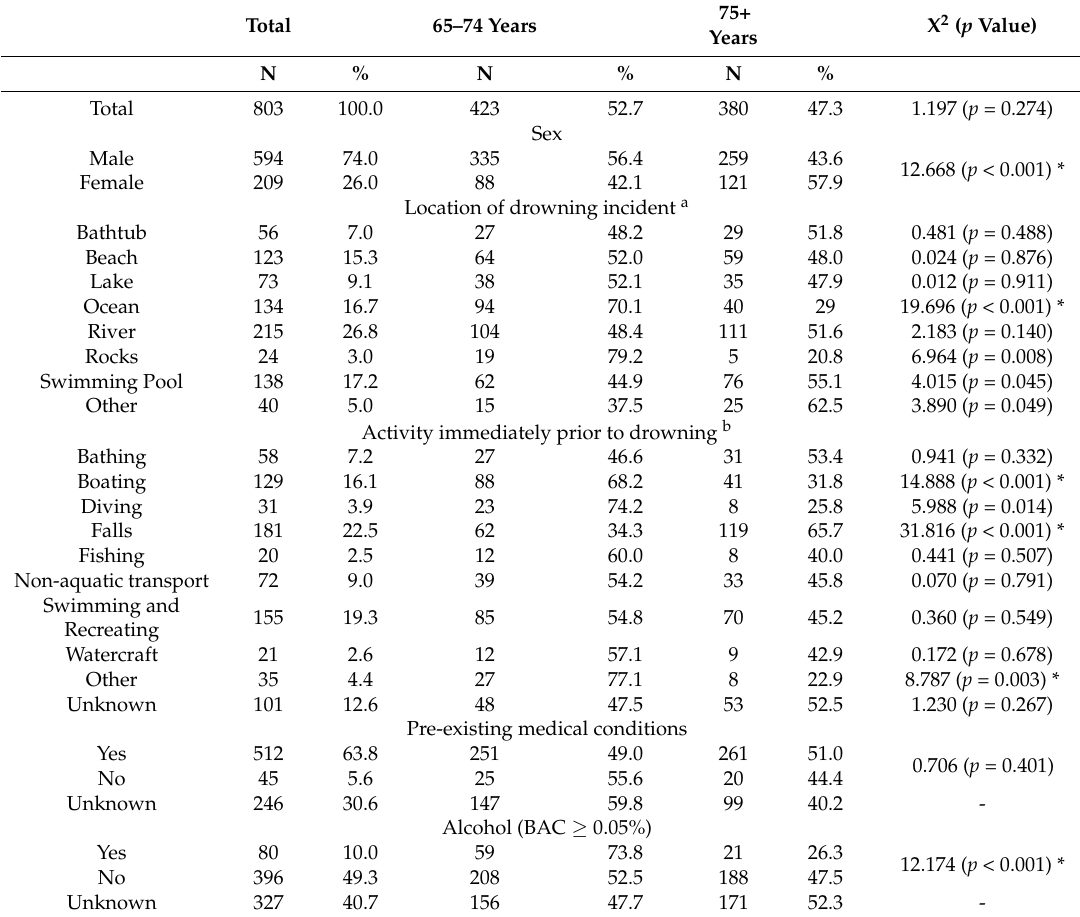
Table 1. Demographics and circumstances of unintentional fatal drowning among people aged 65 years and over, by age group, Australia, 2002/03 to 2016/17 (N =